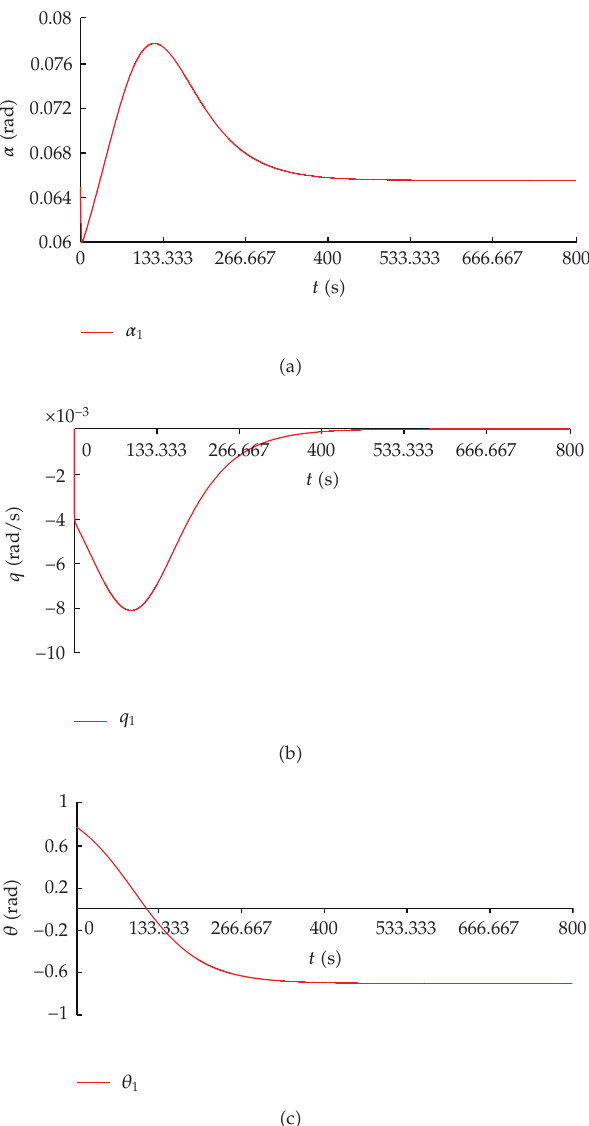
(cid:7) 0 . 03026 (cid:5) rad (cid:6) (cid:7) 1 . 734 ◦ . α (cid:6) (cid:7) e 2 (cid:7) 0 . 065516 (cid:5) rad (cid:6) (cid:7) 3 . 755 ◦ ; 1 (cid:7) 0 . 064883 (cid:5) rad (cid:6) (cid:7) 3 . 719 ◦ ; q (cid:6) (cid:7) 0 (cid:5) rad / s (cid:6) ; 2 2 (cid:7) 0 (cid:5) rad / s (cid:6) ; θ (cid:6)(cid:6) (cid:7) 1 . 03669718 (cid:5) rad (cid:6) (cid:7) 2 2